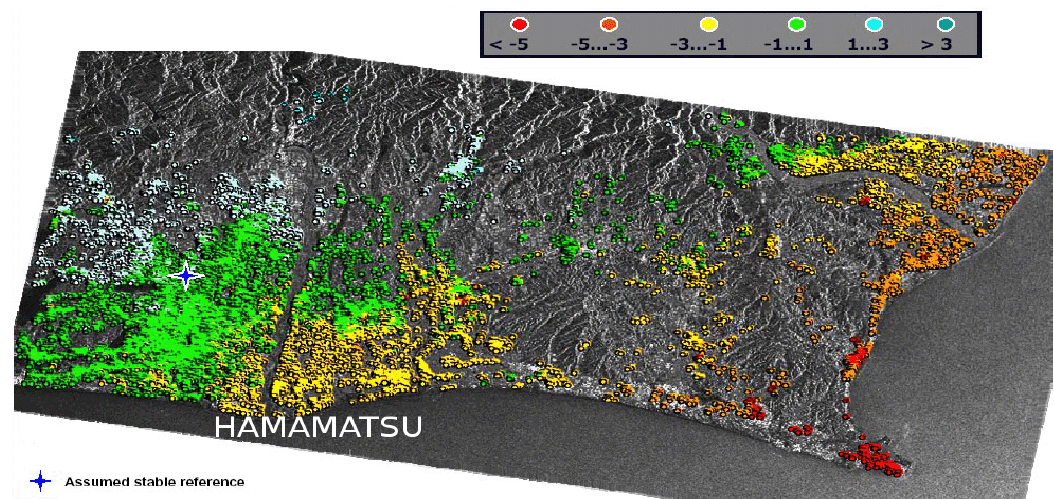
Figure 6. Average displacement rate in Tokai area, Japan, 1992–2000 years, vertical deformation, mm/year